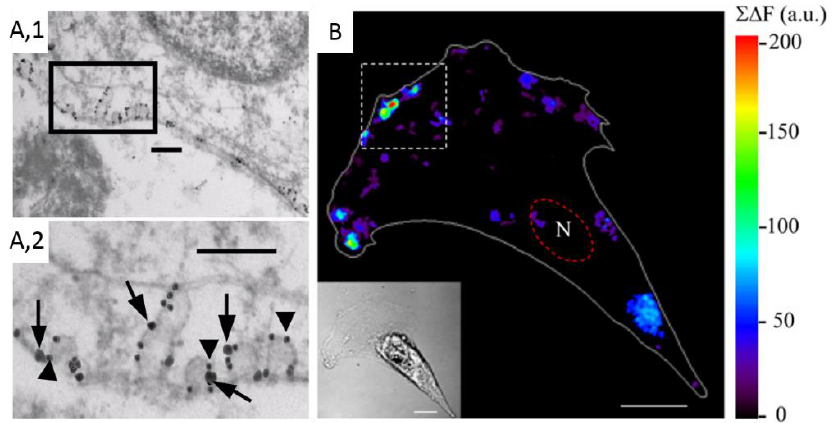
Figure 8. Illustration of the interplay between lipid domains and Ca 2+ signaling. ( A ) Association of a Ca 2+ channel with caveolae (A,1; zoom in A,2). Immunogold colocalization of the Ca v 1.2 subunit of L-type Ca 2 + channel (large particle, arrows) and caveolin 3 (small particle, arrowheads) in the caveolae in isolated mouse cardiomyocytes. Scale bars, 200 nm. Reproduced from [331]. Copyright (2006) National Academy of Sciences, USA. ( B ) Ca 2+ domains in migrating cells. Local Ca 2+ increases (ΣΔF) were summed over 30 consecutive images acquired at 6 s intervals. N points to the nucleus of the fibroblast. Scale bar, 15 µm. Reproduced from [333].